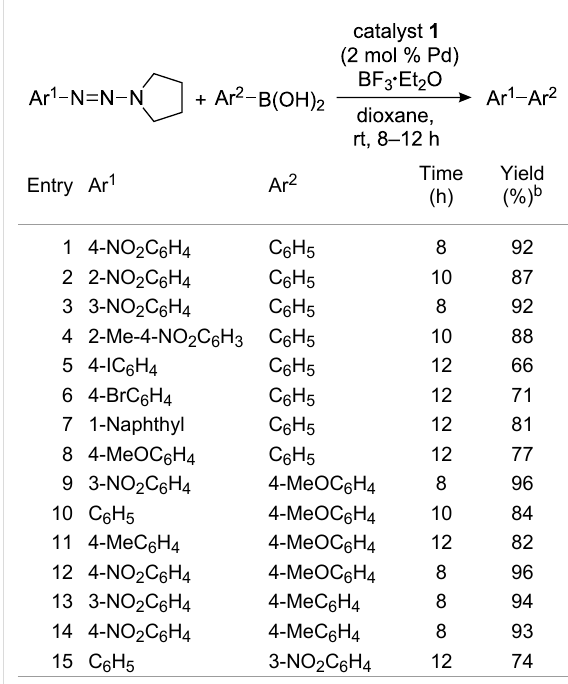
Table 5: Cross-coupling of 1-aryltriazenes and arylboronic acids cata- lyzed by the polystyrene-supported NHC–Pd catalyst a .